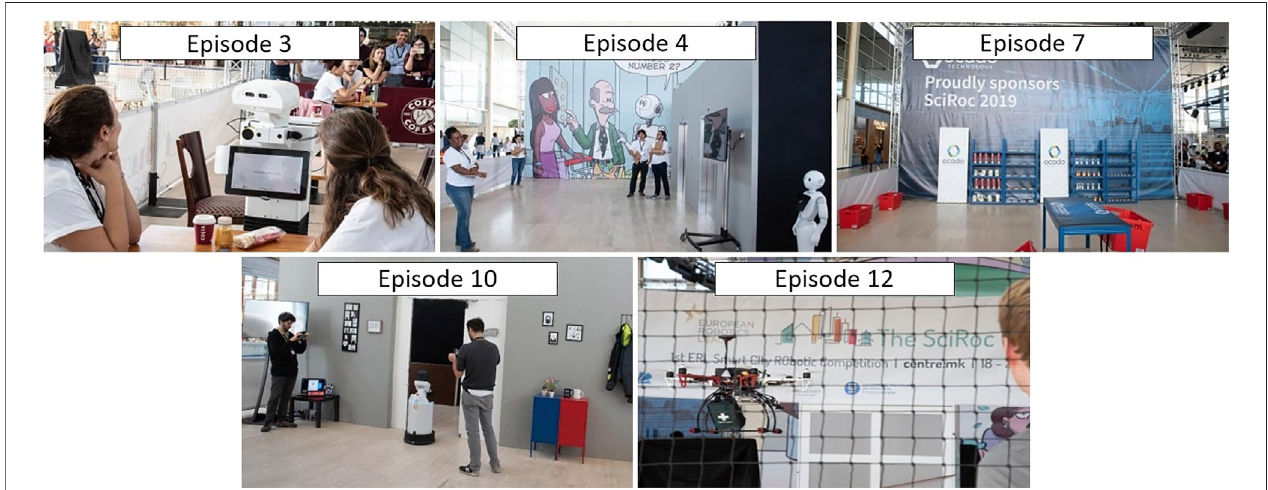
FIGURE 5 | Pictures taken during the competition showing different robots engaging in the various challenges.